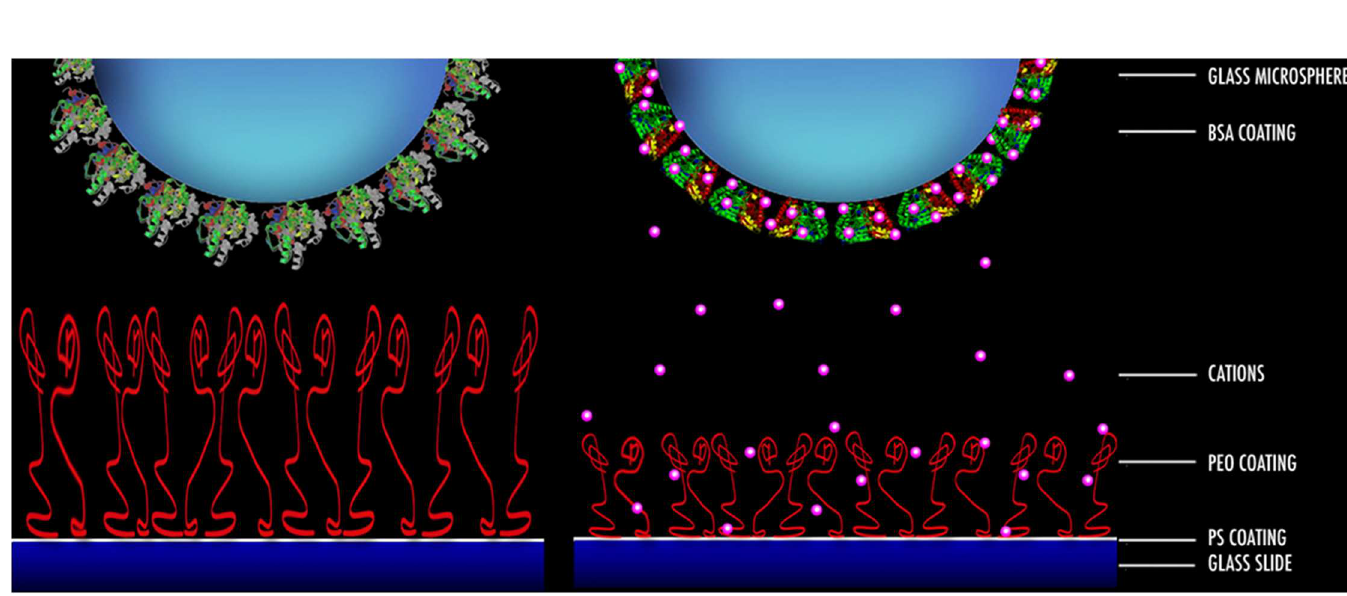
Fig 5. Schematic illustration of the interaction between BSA and PEO at pH above the pI of the protein in water (left frame)and in electrolyte solution (right frame). Shrinkingof BSA and PEO has been intentionally exaggerated.